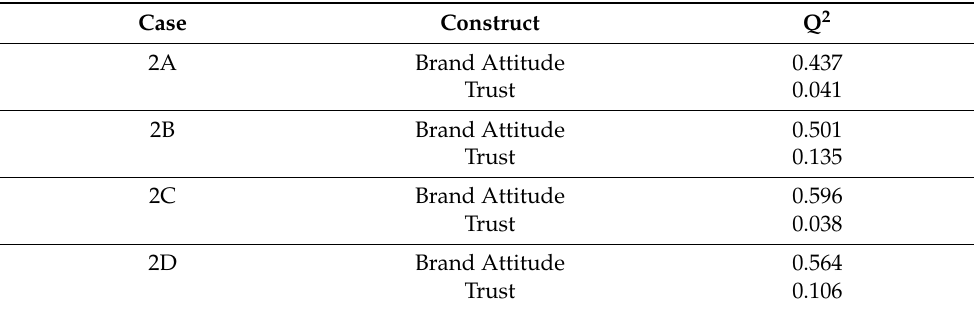
Table A9. Predictive Relevance of each case in Public Transport Service